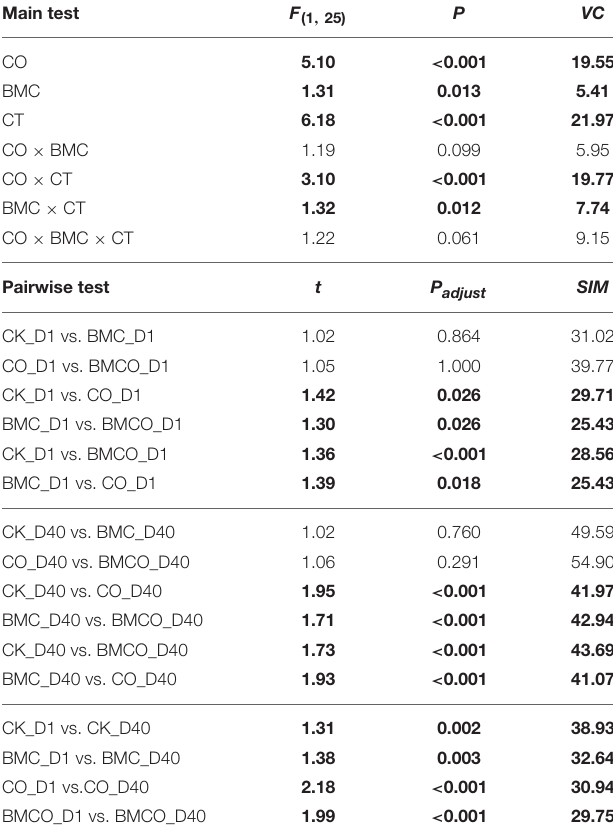
TABLE 4 | Effect of treatments on bacterial β -diversity. TABLE 5 | Distance-based linear modeling examining the relationship